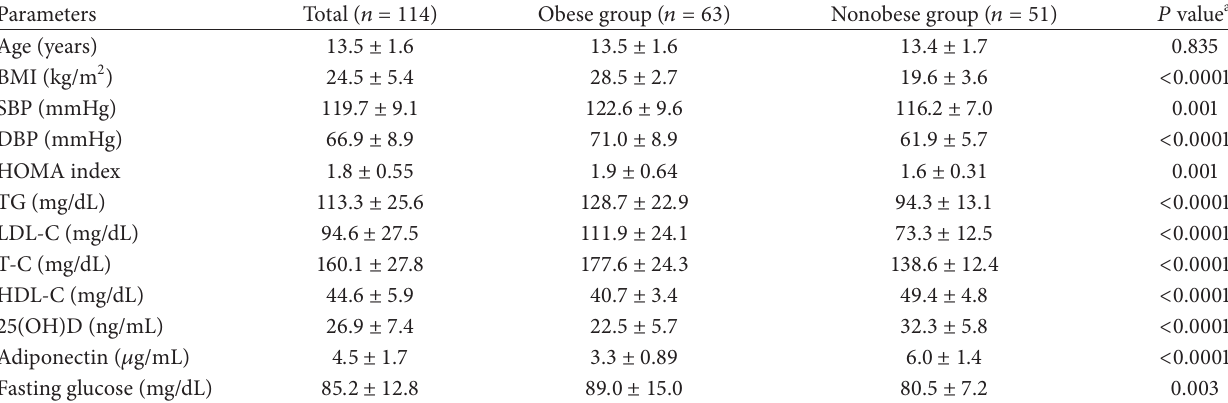
Table 2: Baseline clinical and biological parameters of study subjects.